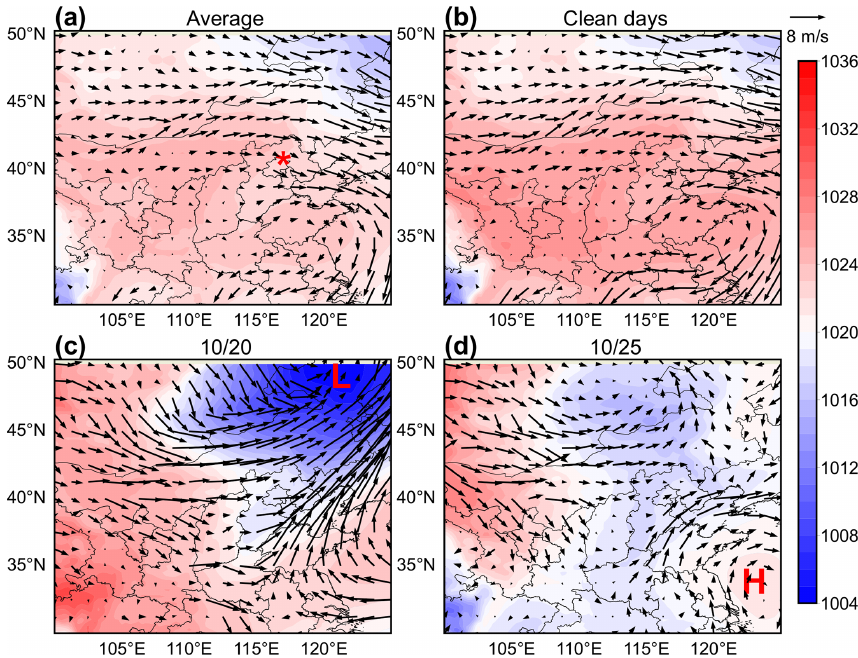
Figure 3. Winds at 925hPa and sea level pressure (hectopascals) derived from ERA5 data (a) averaged during 13–27 October, (b) clean days (13–19 and 21–24 October), and on (c) 20 October and (d) 25 October. The red asterisk in panel (a) shows the location of the SDZ site.